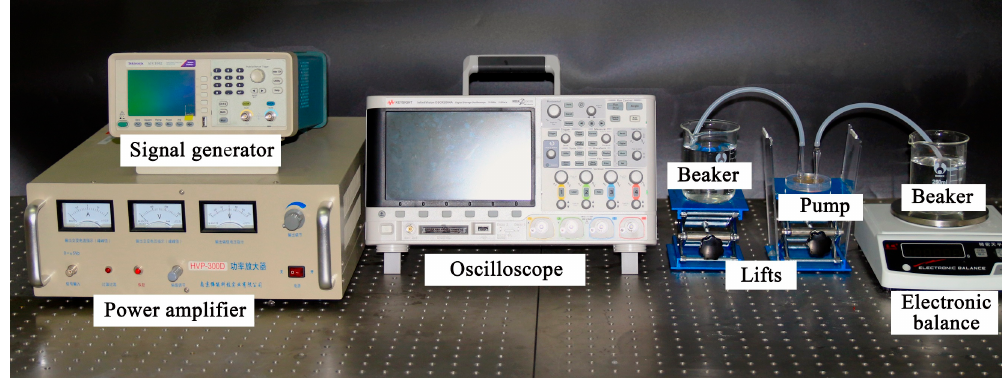
Figure 8. Schematic diagram of the flow device.